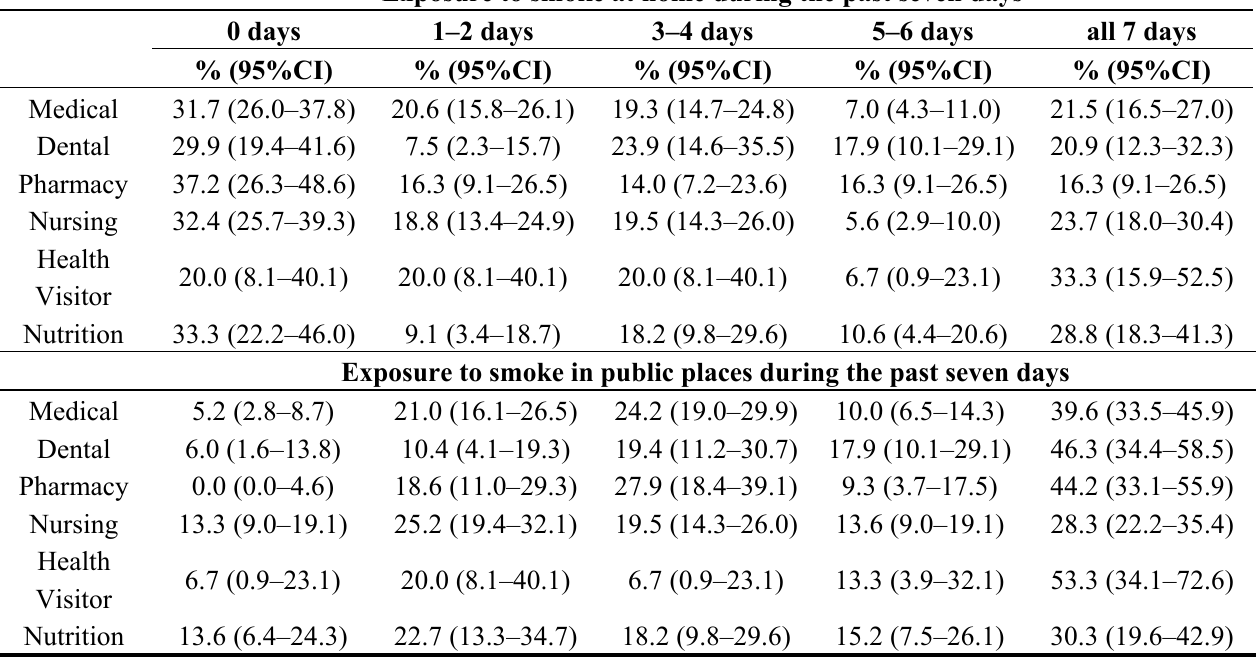
Table 3. Exposure to Secondhand Smoke (only for non-current smokers) among Third-Year Health Professional